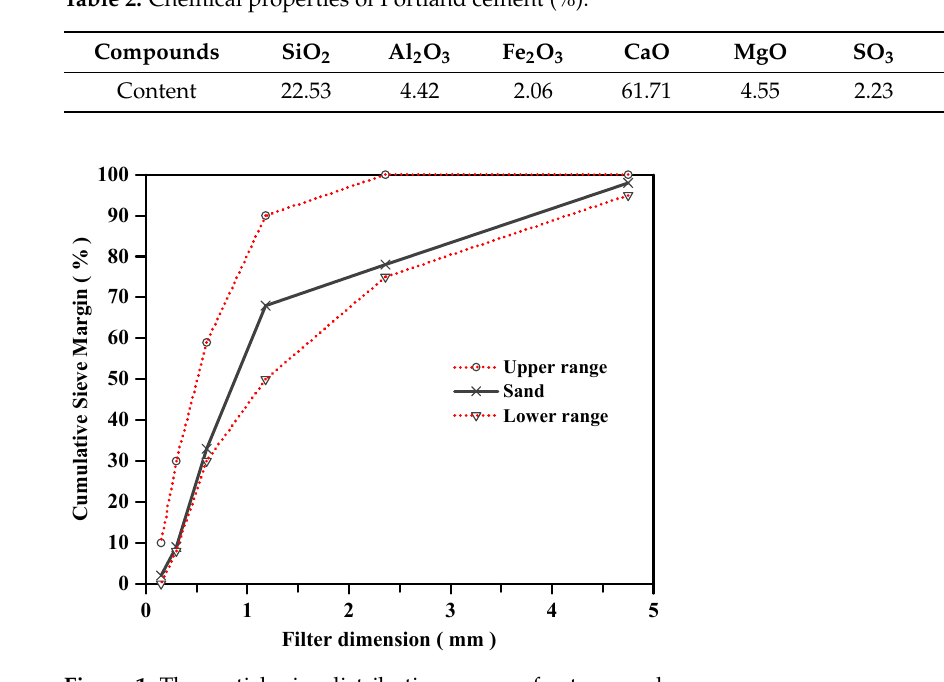
Figure 1. The particle size distribution curves of nature sand.